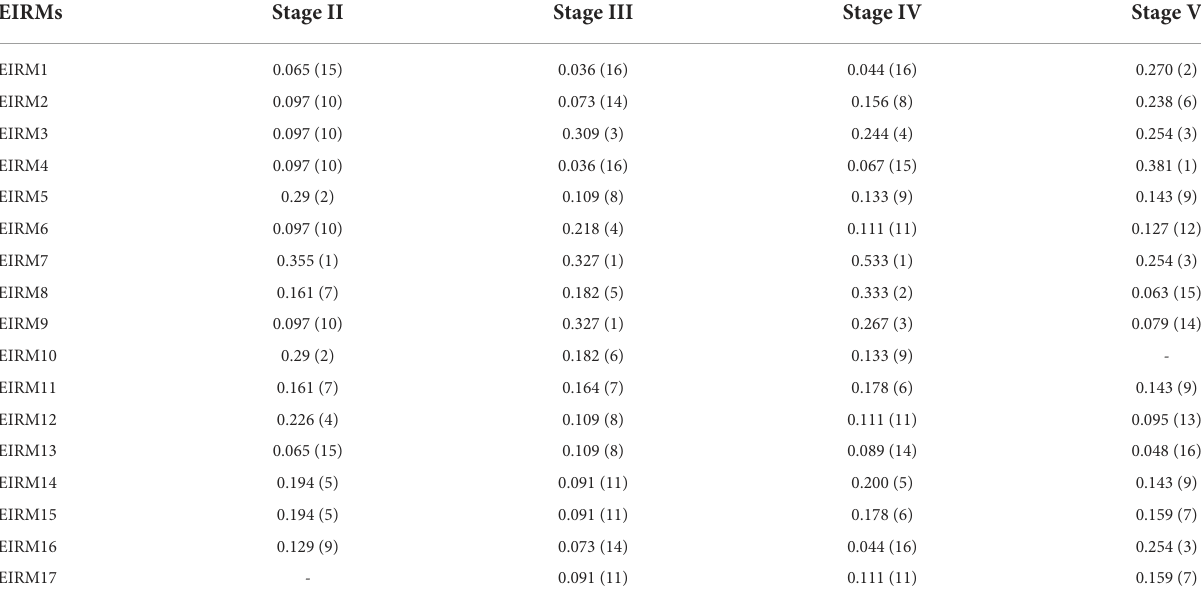
TABLE 8 The normalized degree centrality of EIRMs in Stages II–V. EIRMs Stage II Stage III Stage IV Stage V